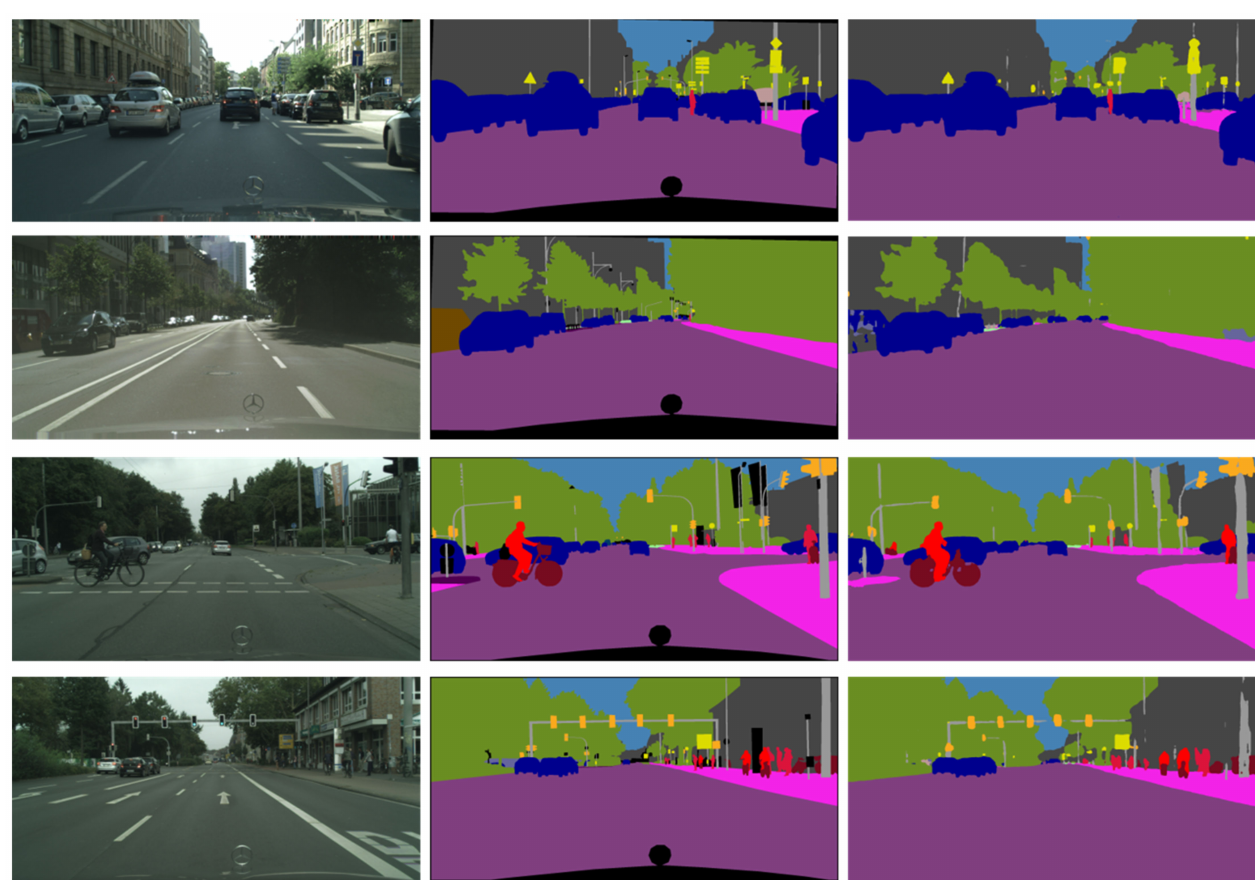
Figure 6. Qualitative results on Cityscapes. First column: Original input images; second column: Labels of ground truth; and Third column: Our segmentation results.